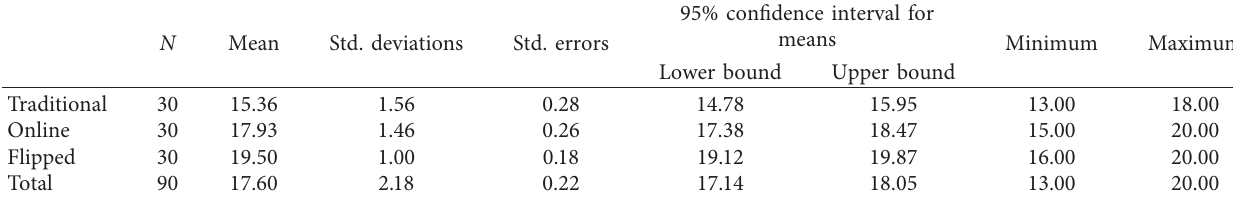
Table 3: Descriptive statistics of the groups in the vocabulary posttest.